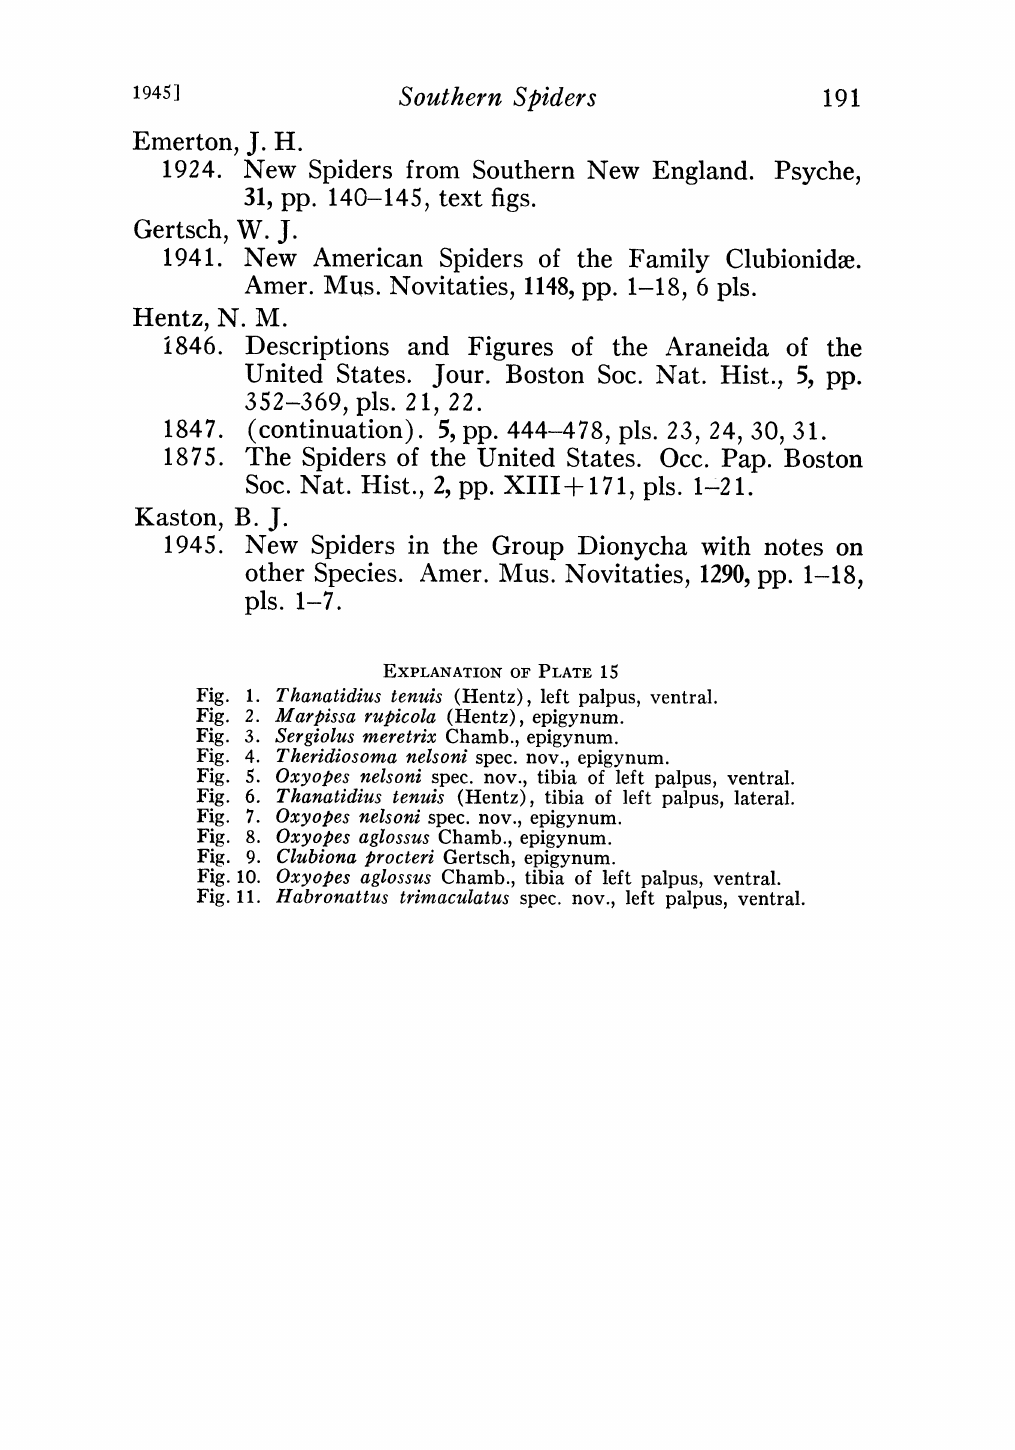
Fig. 2. Marpissa rupicola (Hentz), epigynum. Fig. 3. Sergiolus meretrix Chamb., epigynum. Fig. 4. Theridiosoma nelsoni spec. nov., epigynum. Fig. 5. Oxyopes nelsoni spec. nov., tibia of left palpus, ventral. Fig. 6. Thanatidius tenuis (Hentz), tibia of left palpus, lateral. Fig. 7. Oxyopes nelsoni spec. nov., epigynum. Fig. 8. Oxyopes aglossus Chamb., epigynum. Fig. 9. Clubiona procteri Gertsch, epigynum. Fig. 10. Oxyopes aglossus Chamb., tibia of left palpus, ventral. Fig. 11. Habronattus trimacuIatus spec. nov., left palpus,